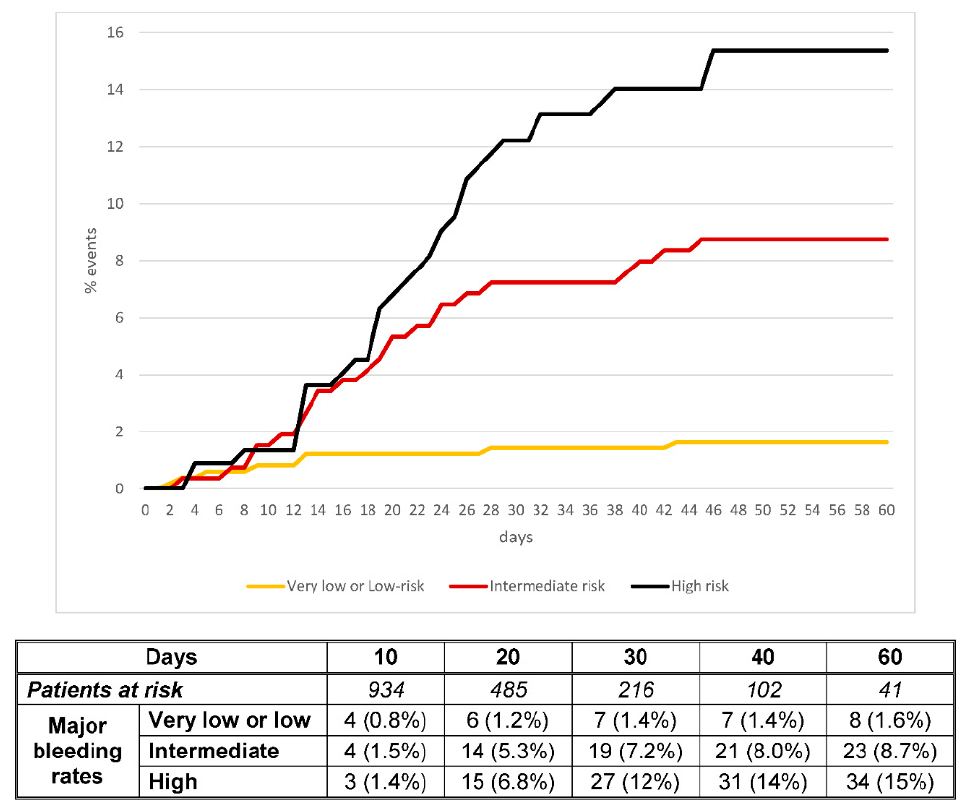
Figure 1. Cumulative incidence of major bleeding according to the prognostic score.